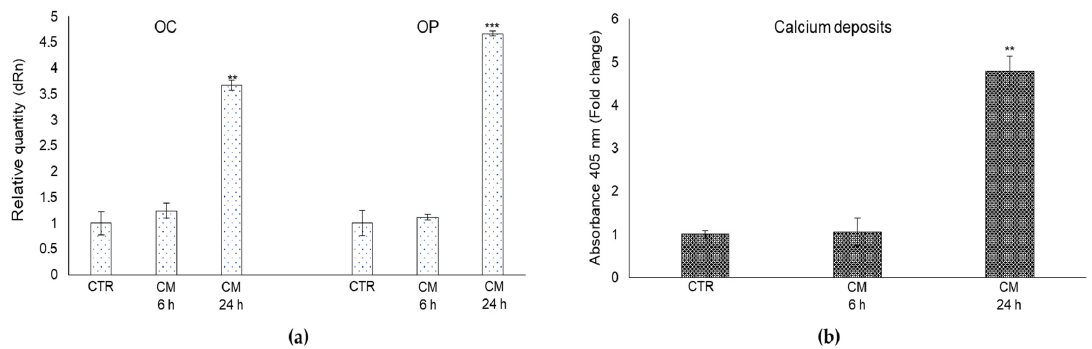
Figure 7. Effect of conditioned medium (CM) from PC3 bone metastasis-derived prostate cancer (PCa) cells on the mRNA expression of some key proteins typically involved in OB extracellular matrix mineralization, namely the non-collagenous protein osteocalcin (OC) and osteopontin (OP) ( a ), and on the formation of calcium deposits in human primary osteoblasts (OB) ( b ). Transcript levels were evaluated by real-time PCR while calcium deposits were measured by the alizarin red staining method in OB exposed for 6 and 24 h to CM from PC3 cells. Control cells (CTR) are represented by OB cultured for the same period of time in their specific growth medium. Two experimental CTRs were performed for each exposure time; being both of them set at 1, each histogram reports only one CTR. The histogram indicates the mean ± SD of two different cultures, and each was tested in triplicate. ** p < 0.01, *** p < 0.001.